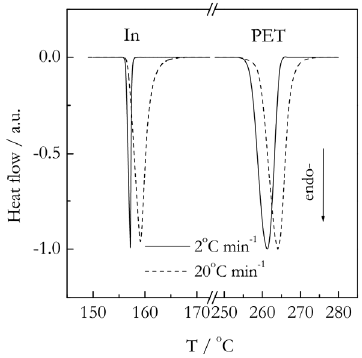
Figure 8. Normalized DSC curves for melting of indium (In) and poly(ethylene terephthalate) (PET) at the heating rates 2 and 20 °C min − 1 . PET data adapted from Vyazovkin [81]. Copyright 2014 Wiley ‐ VCH.